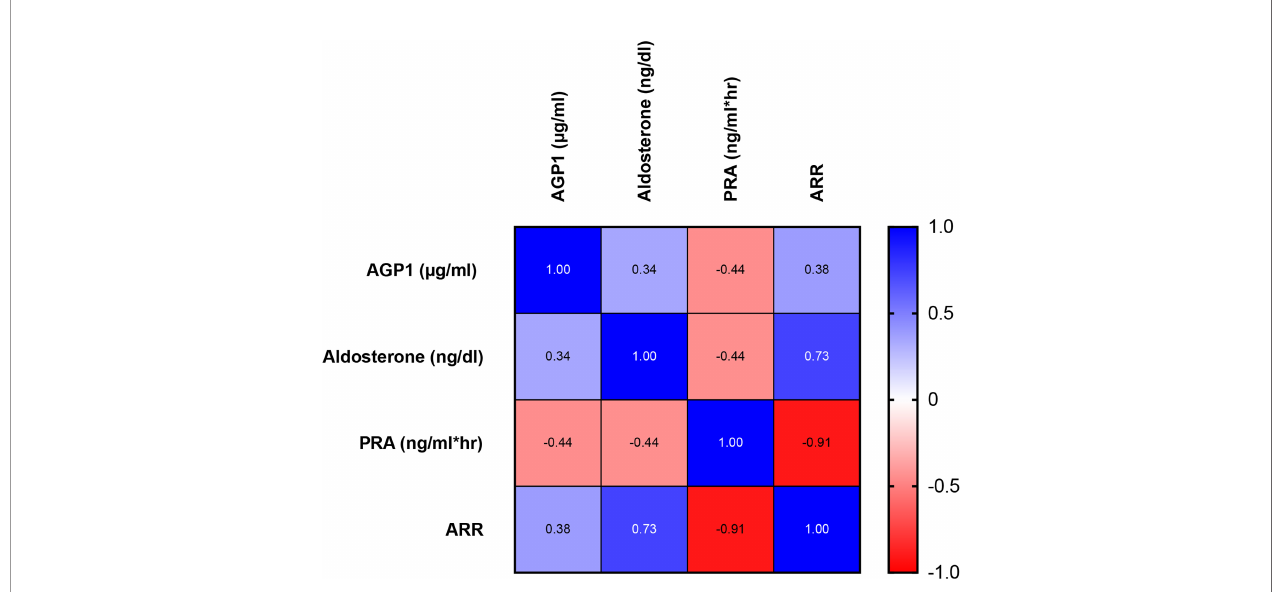
FIGURE 5 | Heat map of AGP1 associations with serum Aldosterone, PRA, and ARR in PA, EH, and CTL subjects. Positive associations are presented in blue gradient with the respective r (rho) value. Similarly, negative associations are presented in the red gradient. We observed a signi fi cant association between AGP1 concentration and the 3 relevant biochemical parameters in primary aldosteronism screening. Association studies were performed by Spearman test, p <